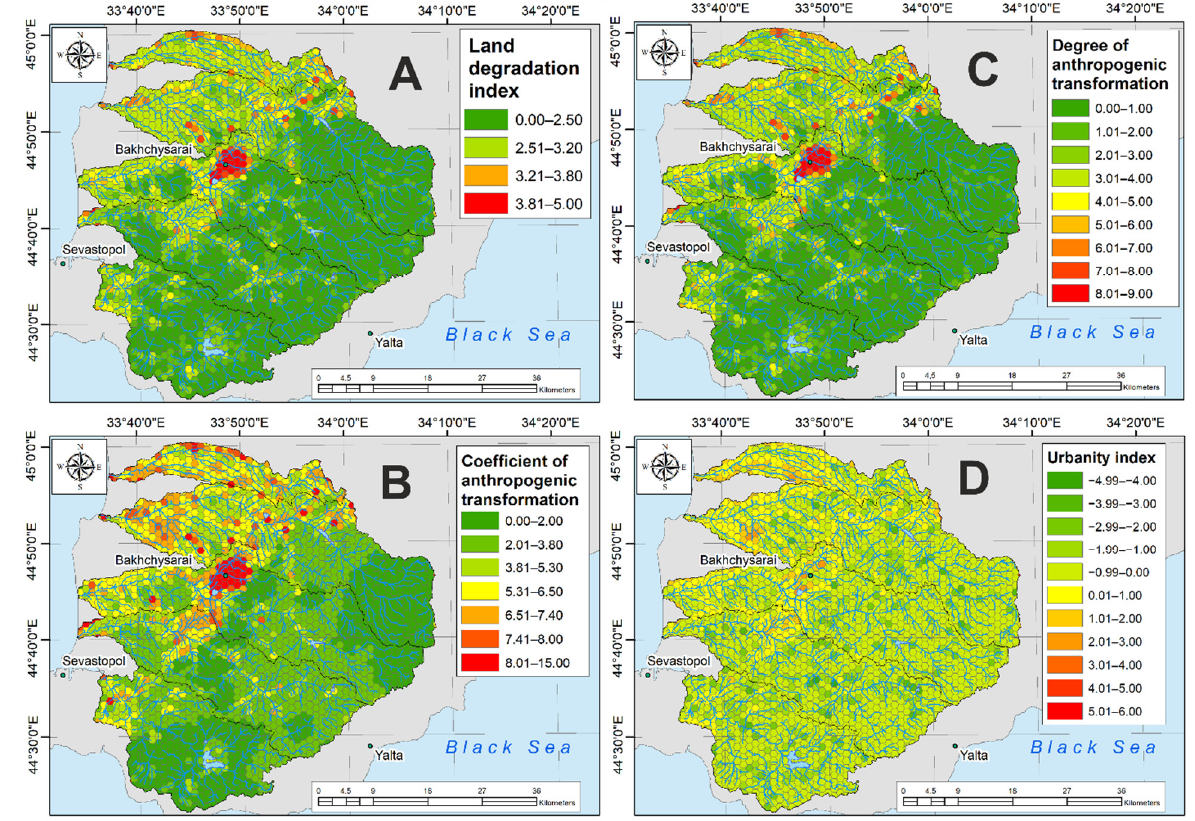
Figure 2. Anthropogenic transformation of the river basins of the northwestern slope of the Crimean Mountains: ( A ) land degradation index; ( B ) coefficient of anthropogenic transformation; ( C ) degree of anthropogenic transformation; ( D ) urbanity index.